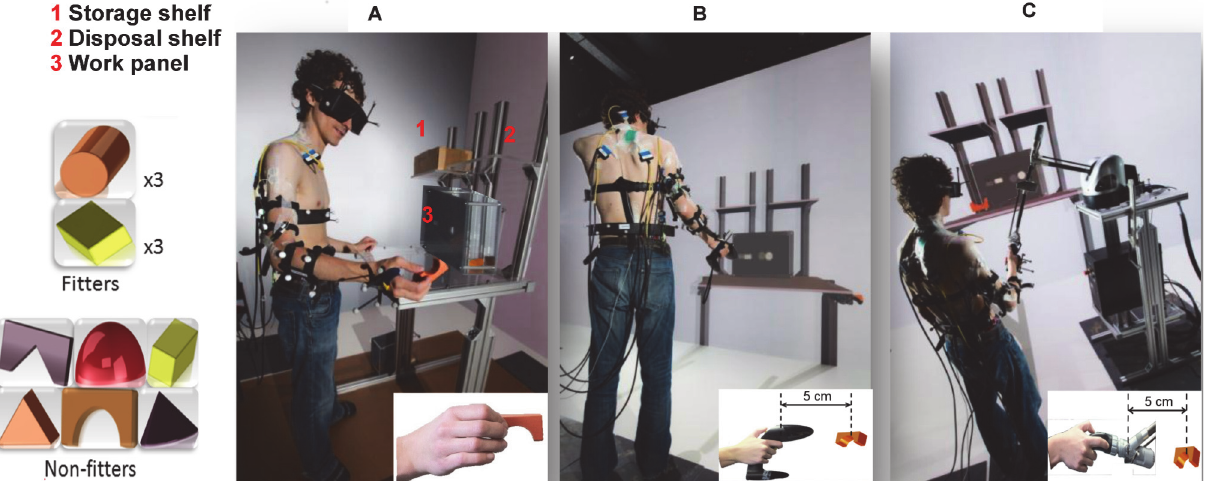
Fig 1. Illustration of the work place within the three platforms, i.e., a) real, b) virtual and c) virtual with force feedback. The participants stood in front of a work table adjusted to their elbow height and had to grasp an object from the storage shelf with the right hand. The participants had to pass the “ fitter ” objects through the work panel and laid the “ non-fitter ” objects on the disposal shelf. Consent to publication was obtained from the participant seen in the